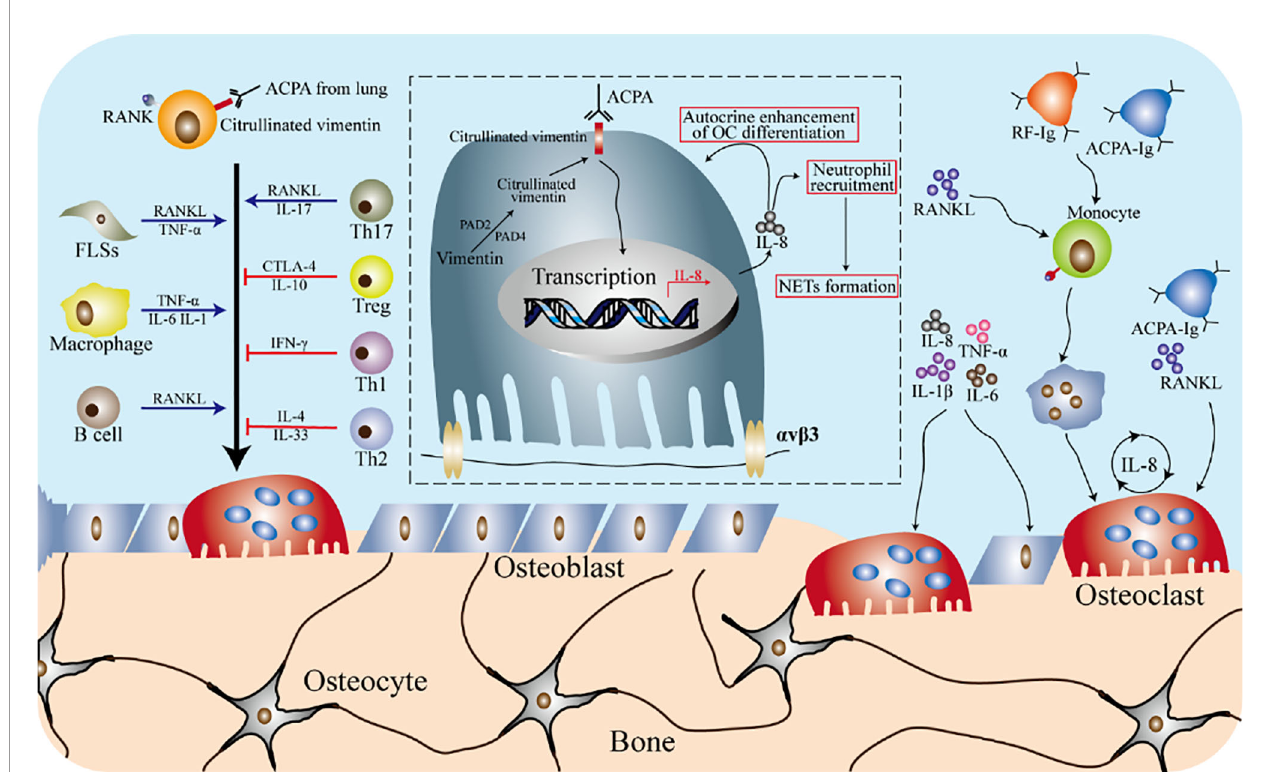
FIGURE 7 | Osteoimmunity in rheumatoid arthritis. The formation of osteoclasts is the result of a variety of immune cells and cytokines in the rheumatoid arthritis (RA) environment. In the in fl ammatory environment of RA, fi broblast-like synovial cells (FLSs) produce RANKL and TNF- a , and macrophages can produce pro- in fl ammatory cytokines (such as IL-1 b , TNF- a and IL-6), which promote the differentiation of osteoclasts. B cells and T cells participate in the differentiation and activation of osteoclasts by secreting cytokines. ACPA speci fi c to citrulline vimentin can induce the differentiation of osteoclasts precursors and promote the in fl ammatory response of RA. IL-8 increases the differentiation of osteoclasts precursors in an autocrine manner, and also participates in the recruitment of neutrophils as a chemokine. The NETs formed by the recruited neutrophils play a role in amplifying the in fl ammation of the synovial tissue, thereby developing RA. Cytokines such as TNF- a , IL-1 b , IL6 and IL8 are produced by anti-citrullinated peptide antibodies (ACPA) or rheumatoid factor (RF) autoantibodies attacking the monocytes lineage. These cytokines can not only directly increase the formation of osteoclasts, but also regulate the secretion of RANKL from stromal cells, thereby inducing osteoclasts differentiation. In addition, ACPA promotes the secretion of IL-8 by osteoclasts by affecting